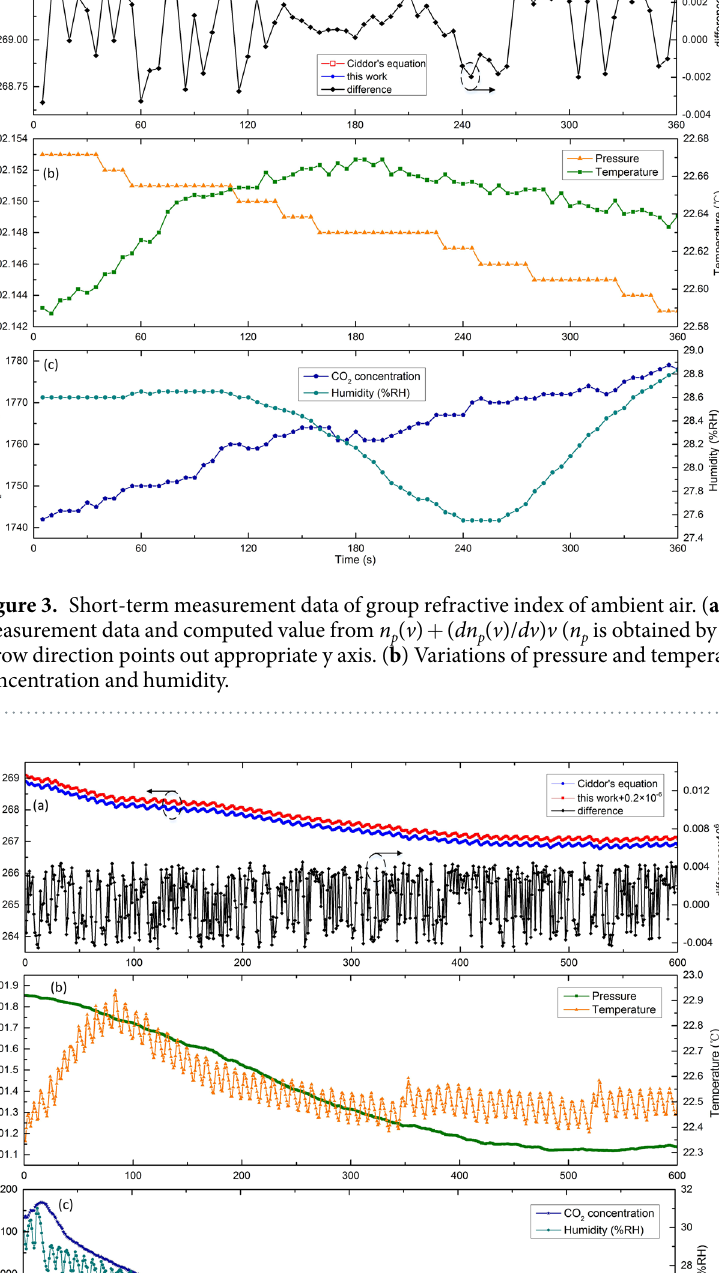
error is 0.6 μ m. Besides, window deformation caused by atmospheric pressure difference is 0.56 μ m. Above all, the